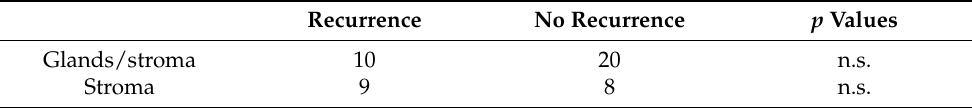
Table 2. Recurrence of catamenial pneumothorax (CP) cases with glands/stroma or stroma for CPE and